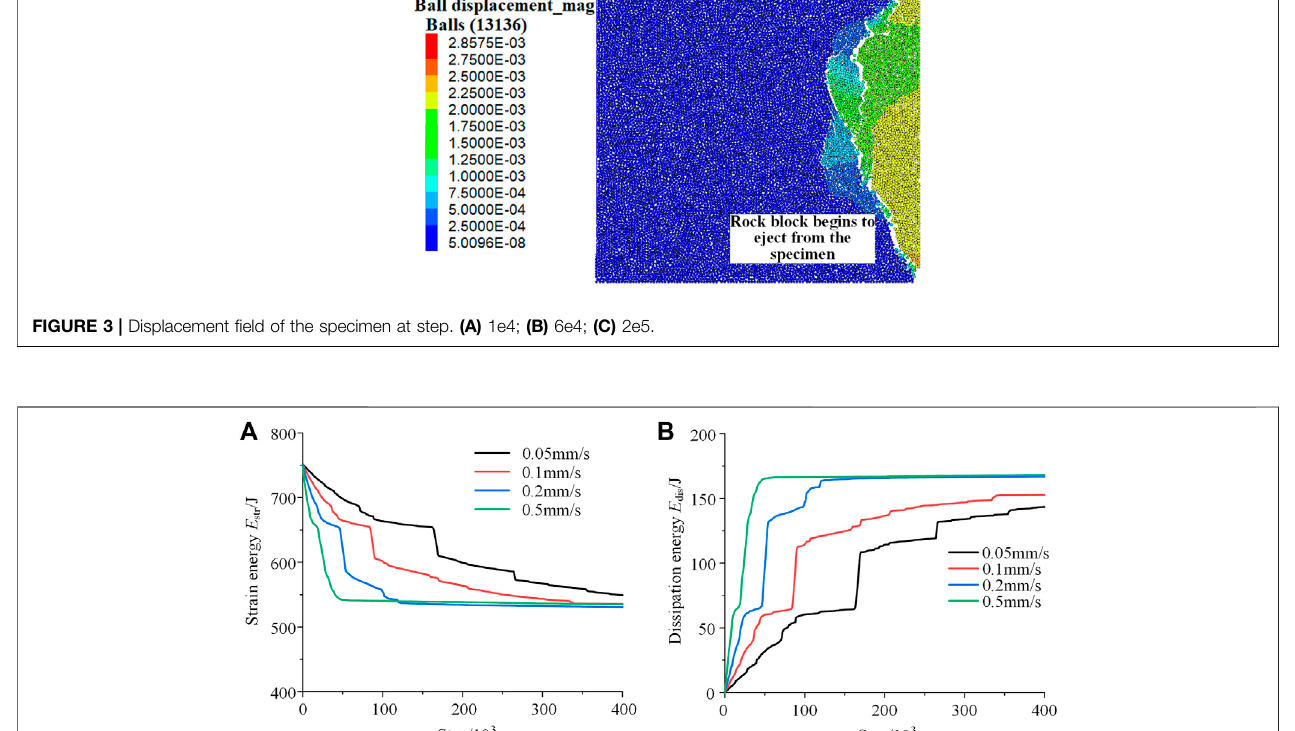
FIGURE 4 | (A) Energy release and (B) energy dissipation process of granite under different unloading velocities.